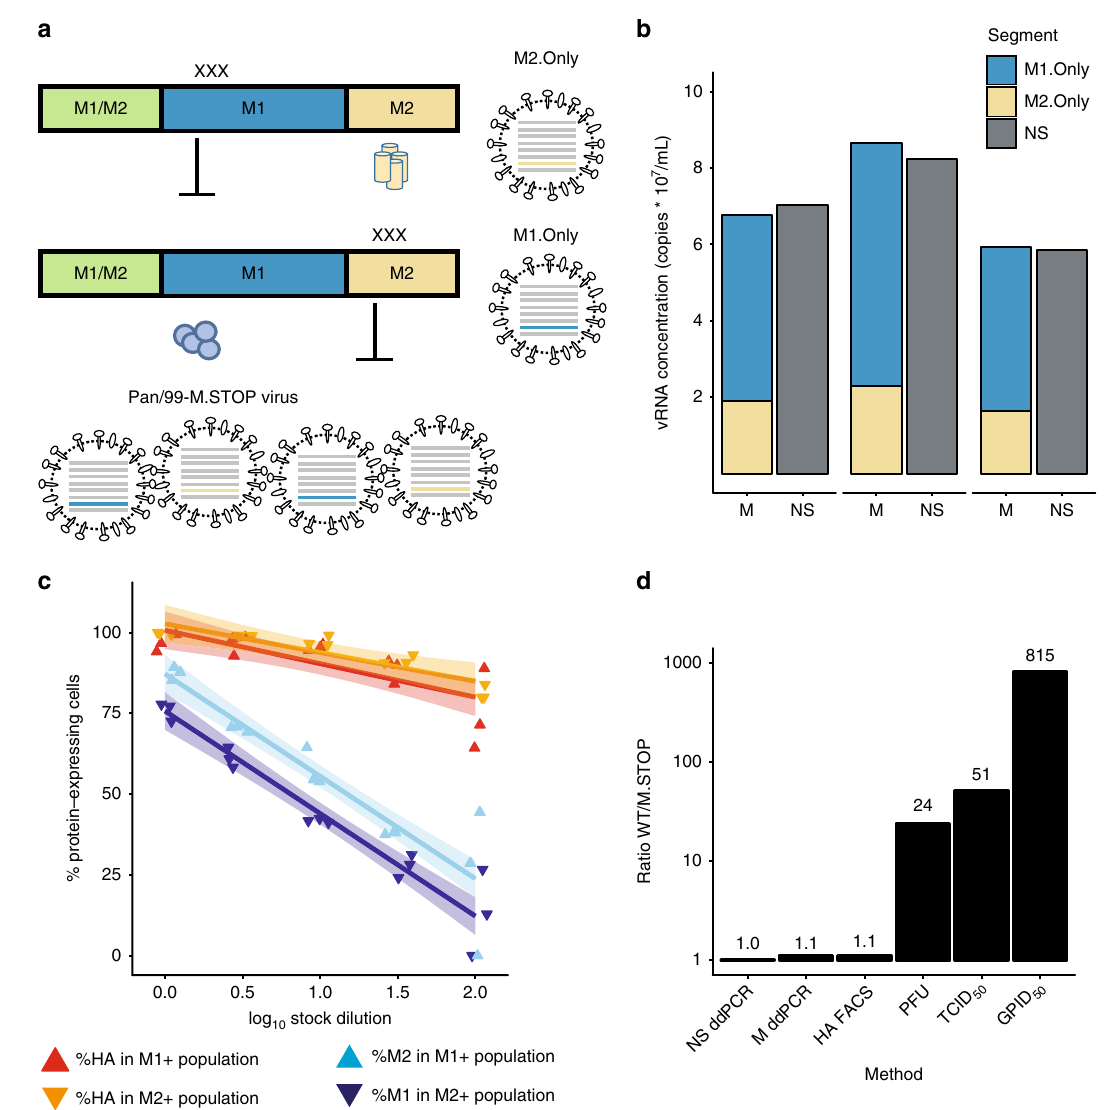
Fig. 7 Dependence on complementation hinders viral infectivity. a Mutation scheme used to generate M1.Only and M2.Only segments, and Pan/99-M.STOP virus. b Copies of M1.Only, M2.Only, and NS segments in three separate aliquots of Pan/99-M.STOP virus stock were quanti fi ed by digital droplet PCR. c Cells were inoculated with Pan/99-M.STOP virus, and incubated under single-cycle conditions before staining for HA, M1, and M2 expression ( N = 3 replicates per dilution). The percentage of cells expressing M1, M2, and HA within M1 + or M2 + subpopulations is shown at each dilution. Lines represent linear regression with shading representing 95% CI (mean±1.96 * SE). d Titers of WT and M.STOP virus stocks were quanti fi ed by ddPCR targeting the NS segment ( N = 2 (WT) or 3 (M.STOP) replicates), ddPCR targeting (any) M segment ( N = 2 (WT) or 3 (M.STOP) replicates), immunotitration by fl ow cytometry ( N =